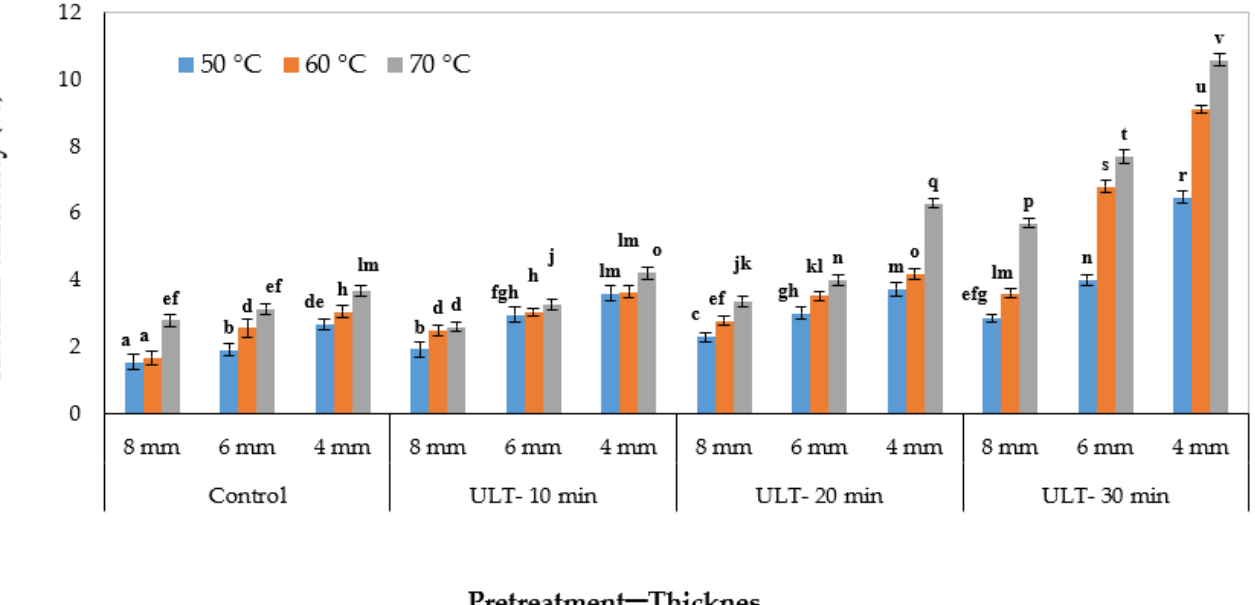
Figure 6. Thermal efficiency under different conditions for drying kiwifruit slices.